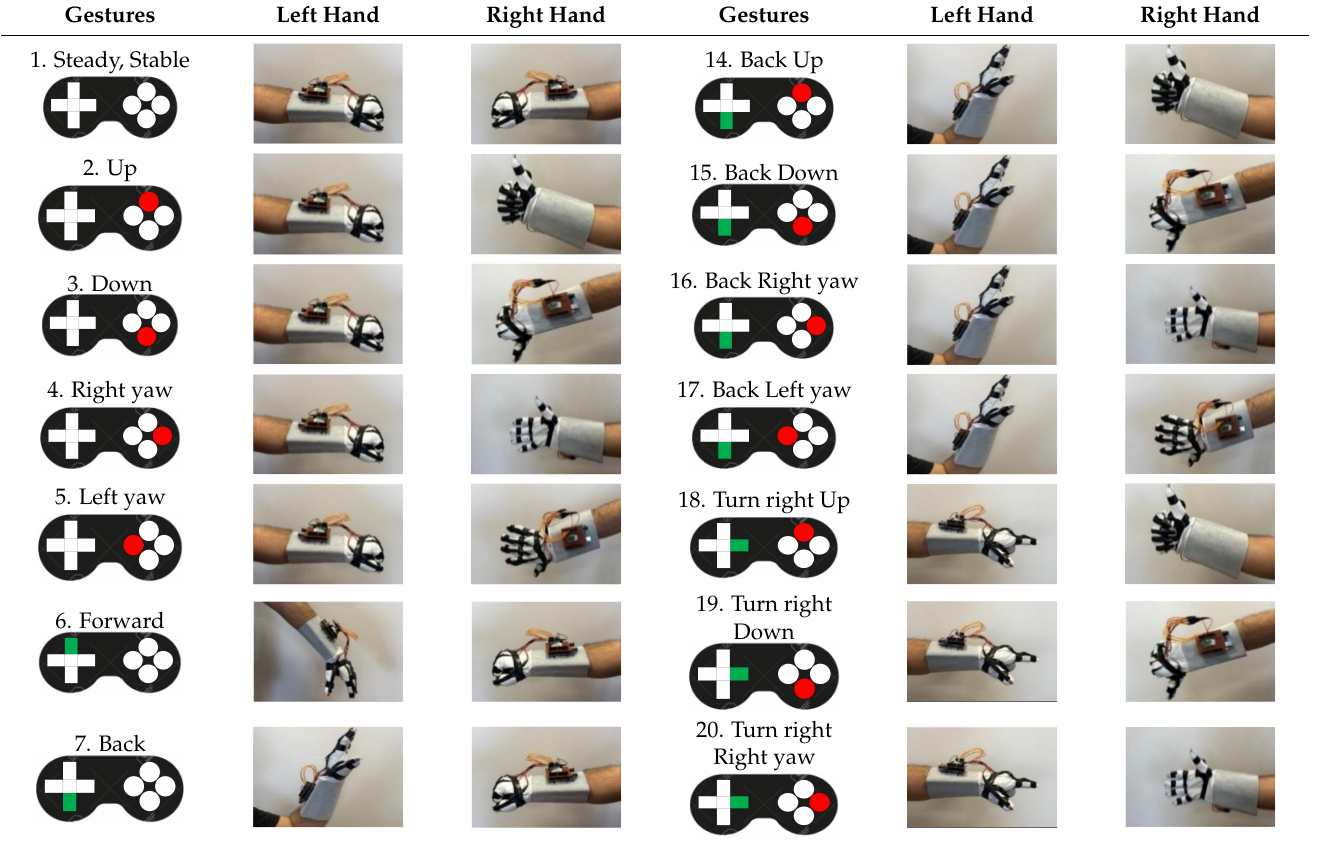
Table 5. Twenty-five different hand movements defined with the help of smart gloves worn on the right and left hands to redirect the UAV.